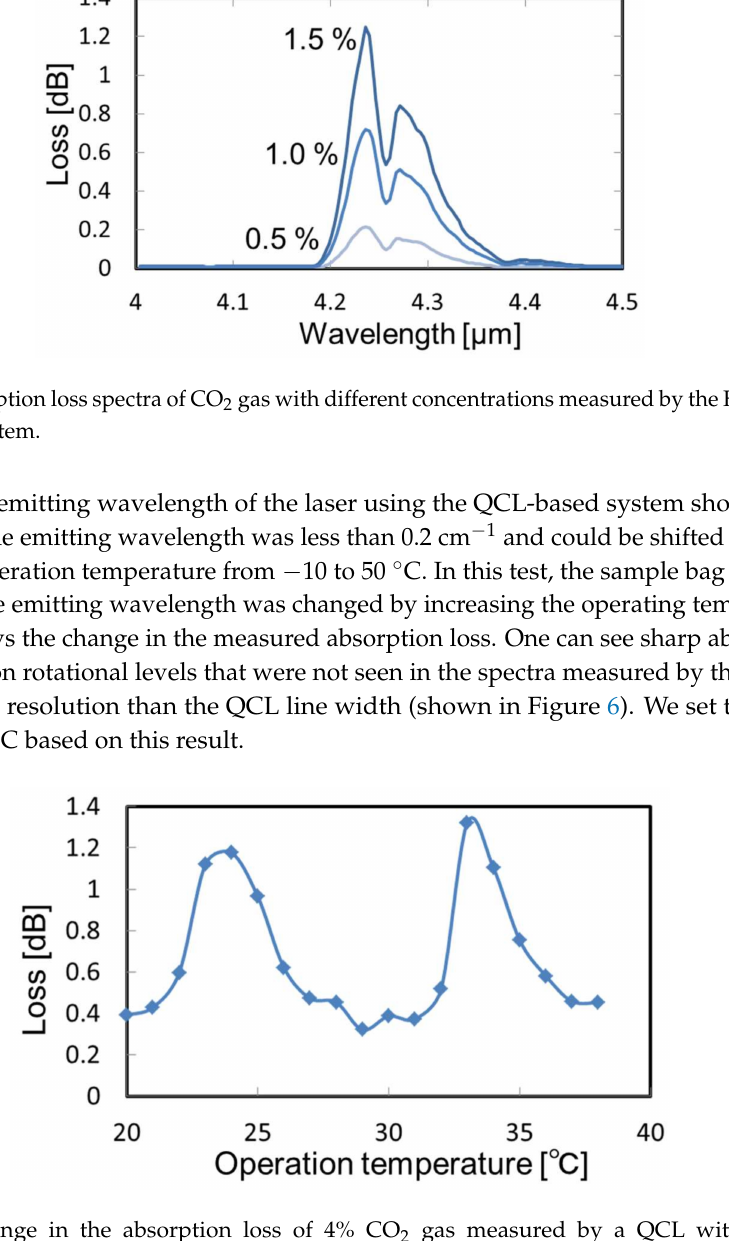
Figure 7. Change in the absorption loss of 4% CO 2 gas measured by a QCL with different operating